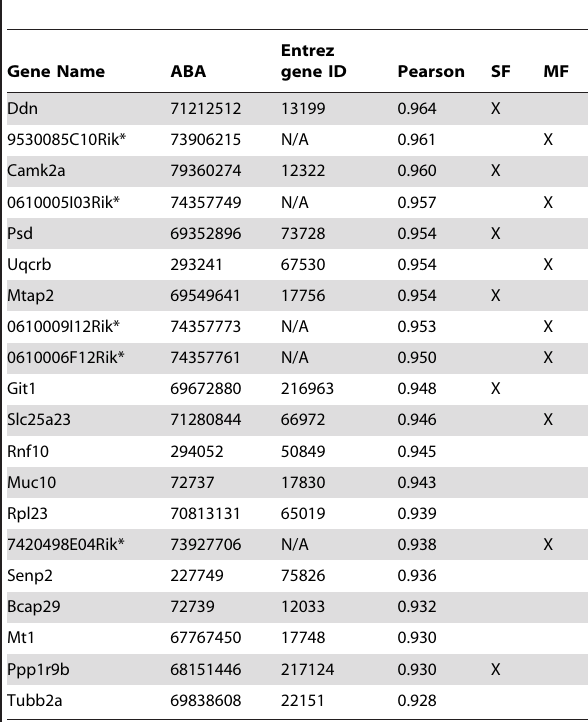
Table 2. List of the top-scoring 20 protein-coding genes defined by the